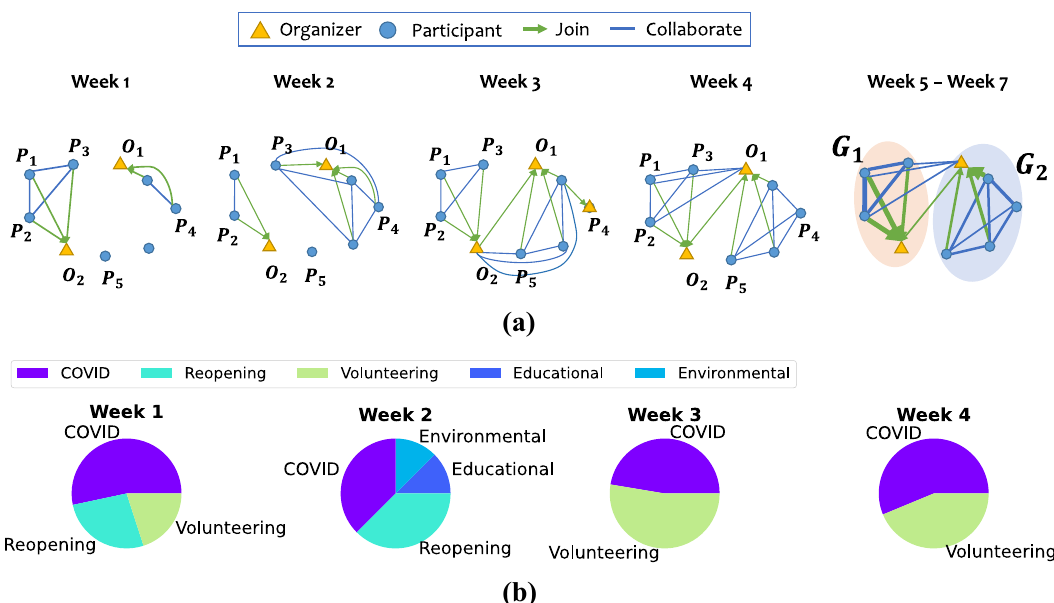
Fig. 1 Self-organised volunteer behaviour patterns. a A sample graph showing the social interactions of Pioneers users in different weeks. Each directed edge P i ! O j indicates that user P i (denoted by a circle) participated in a task issued by organiser O j (denoted by a triangle) in this week. Likewise, an undirected edge indicates the collaboration between two participants in a task. In the fi nal stage of the social graph (i.e., weeks 5 – 7), groups ( G k ) are formed through the volunteering process. The edge widths are proportional to the participation frequencies of speci fi c user pairs. The thicker an edge is, the more often the participant joined the organiser ’ s tasks. b Changes in volunteer task topics posted by an activity organiser as time changes. Generally, organisers tend to focus on several speci fi c task topics after a few attempts.